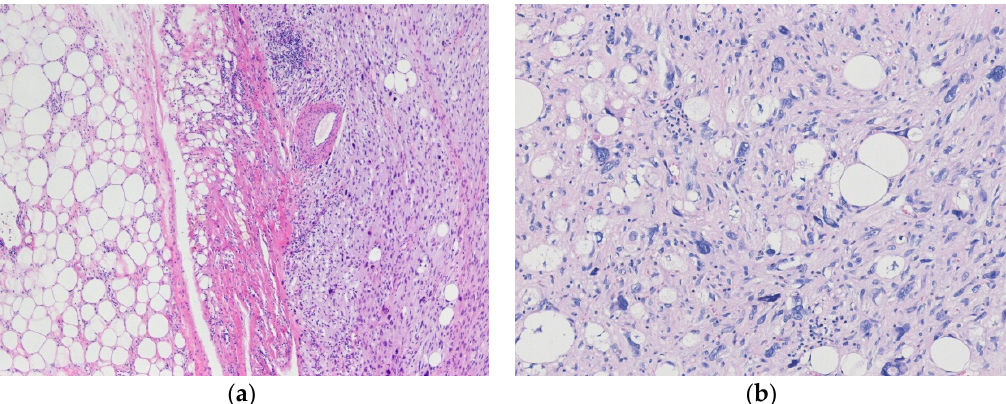
Figure 3. Dedifferentiated liposarcoma with homologous lipoblastic differentiation. ( a ) The tumor shows an abrupt transition from well-differentiated liposarcoma component to dedifferentiated component. ( b ) The dedifferentiated component shows homologous lipoblastic differentiation with scattered lipoblasts. The morphology resembles pleomorphic liposarcoma (H&E stain, original magnifications 100× a and 200× b ).